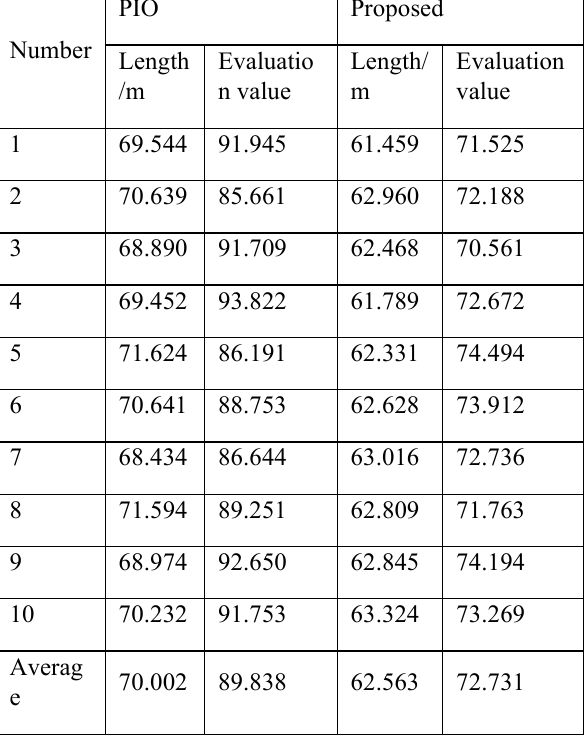
Table 4. Performance comparison between traditional PIO and the proposed algorithm under environment